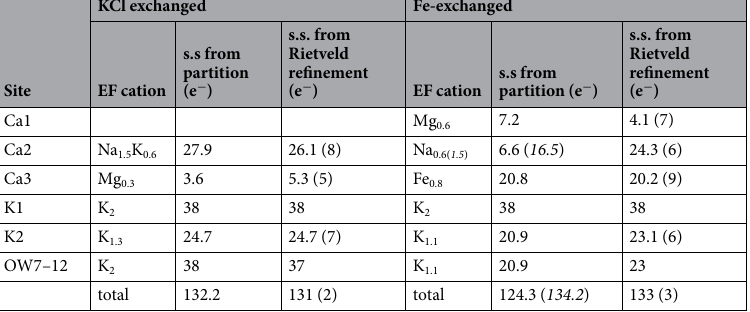
Table 4. Comparison between the site scattering (s.s.) of extra-framework (EF) cation sites calculated from SEM-EDS chemical data (s.s. from partition) and Rietveld refinement (s.s. from Rietveld refinement). In italics, in parenthesis, the same calculation for an estimated content of Na equal to that of the KCl treated sample, due to the very small release of Na detected by ICP-OES. The low Na content observed by SEM-EDS is due to the renewed Na (and possibly K) cation mobility under the electron beam arising from the leaching of the K cations located at the OW